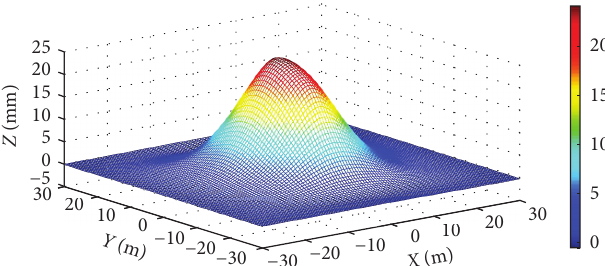
Figure 18: Heaving displacement of ground frost heave caused by freezing for 75 days (mm, α � 10 ° ).